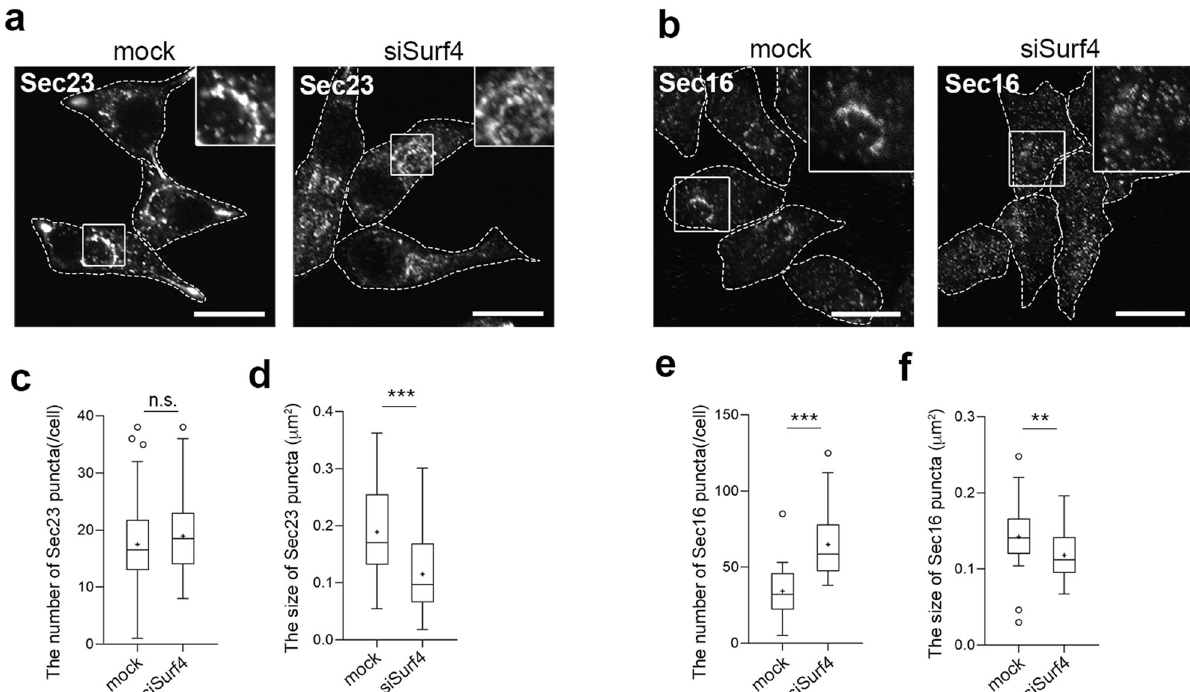
Fig. 6 Loss of Surf4 affects the number and size of the ERES in pancreatic β cells. a INS-1 832/13 cells transfected with the mock or siSurf4 siRNA were fi xed and immunostained with an anti-Sec23 antibody. Dotted lines indicate cell outlines. Scale bars: 10 µ m. b INS-1 832/13 cells transfected with the mock or siSurf4siRNA were fi xed and immunostained with an anti-Secl6 antibody. Dotted lines indicate cell outlines. Scale bars: 10 µ m. c , d Quanti fi cation of the number and size of Sec23-positive punctate structures ( n = 52, mock cells; n = 50, siSurf4 cells). Data are presented as the box and whisker plots and analyzed by two-tailed Mann – Whitney U test, *** p < 0.01; n.s. not signi fi cant. e , f Quanti fi cation of the number and size of Sec16-positive punctate structures ( n = 31, mock cells; n = 32, siSurf4 cells). Data are presented as the box and whisker plots and analyzed by two-tailed Mann – Whitney U test, ** p < 0.05, *** p <